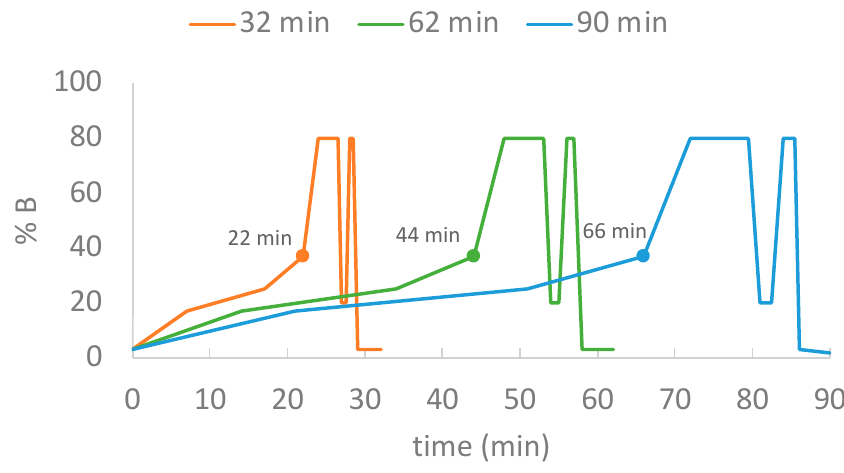
Figure 14. Step-linear gradient duration. The structures of the three step-linear gradients are shown for 22 min (orange 32 min run time), 44 min (green 62 min run time), and 66 min (blue 90 min run time).